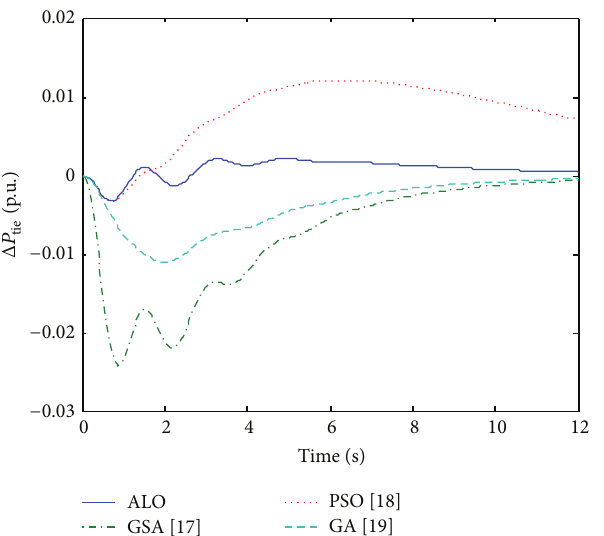
Figure 9: Change in tie-line power by 20% load increase in area 2.